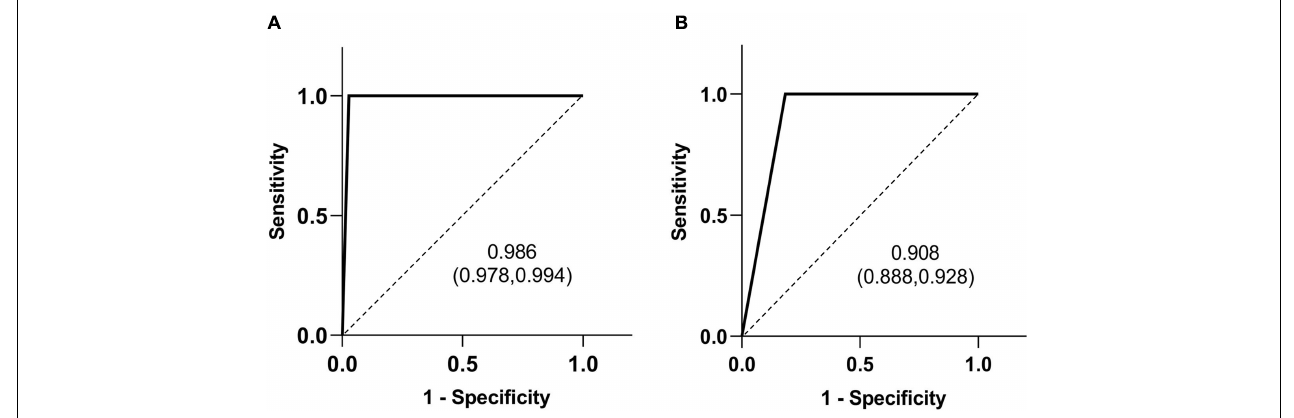
FIGURE 5 | Receiver operating characteristic (ROC) curves of the HSST sign (A) and LAC (B) in differentiating BA. The area under the curve (AUC) value is shown with the 95% confidence interval (CI).